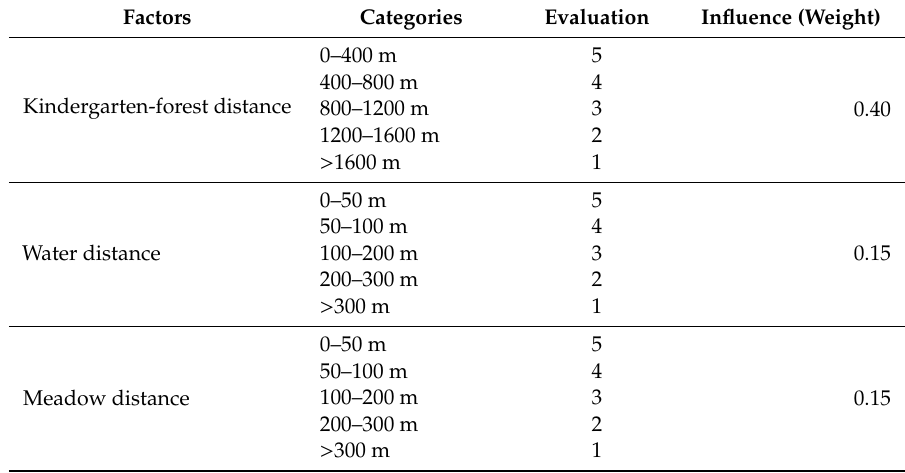
Table 4. The factors used in the model of forest suitability for a visit with kindergarten groups of children with categories, values and